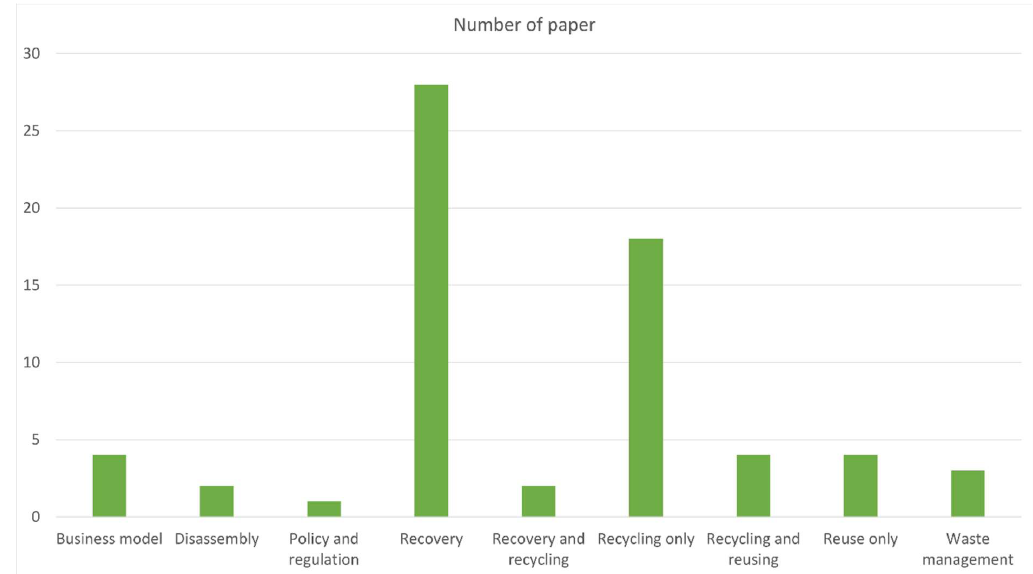
Figure 4. Main subject areas of the reviewed articles (Years of analysis: 2017–January 2022). Table 3. Distribution of papers based on the research fields in lithium-ion battery recycling.